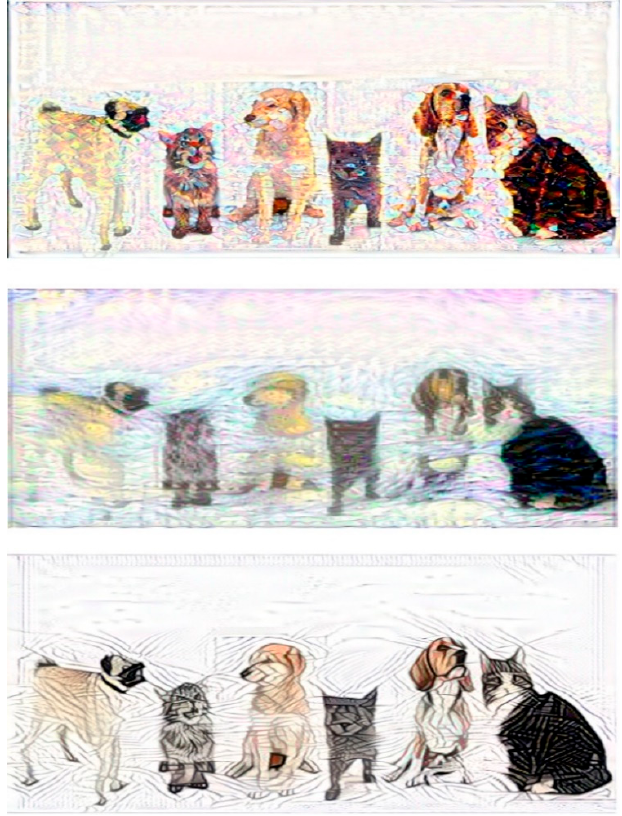
Figure A1. Results of unsuitable NST networks.